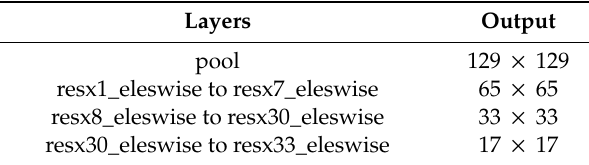
Figure 6. Different building blocks. ( a ): A block of ResNet ( b ): A block of ResNeXt with cardinality of 32. ( c ) A block equivalent to (b). 32. ( c ) A block equivalent to (b). Table 2. The architecture of